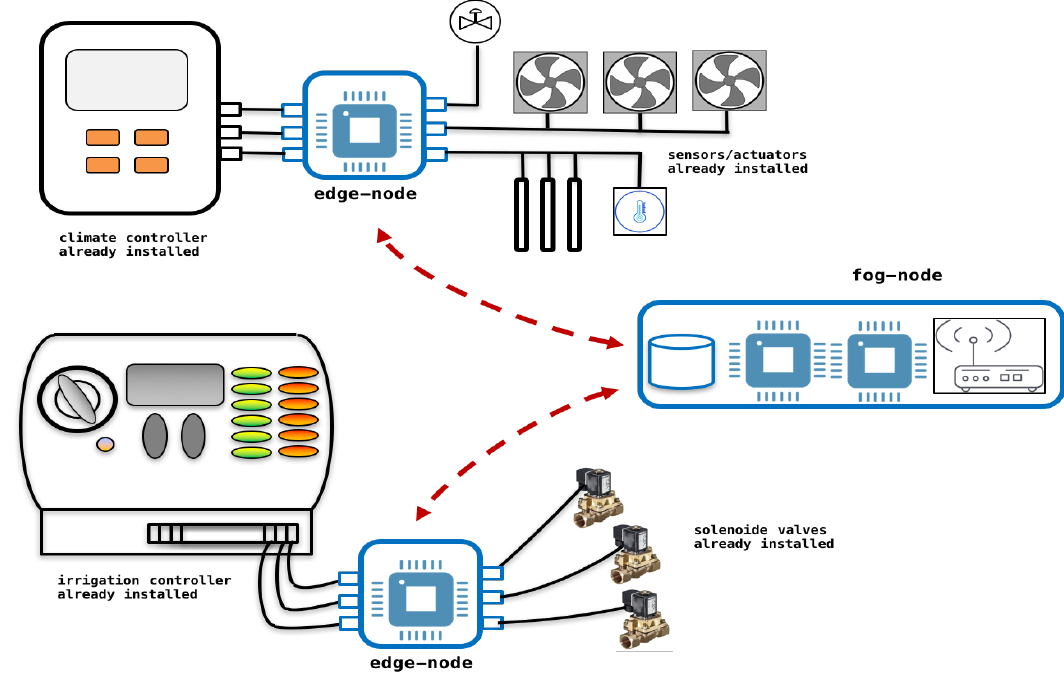
Figure 5. Architecture proposed on facilities already automated: edge nodes interleaved between devices already installed and fog nodes that interconnect all subsystems.